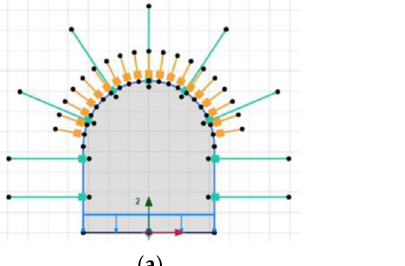
Figure 6. Simulation of the pipe roofings using embedded beams.